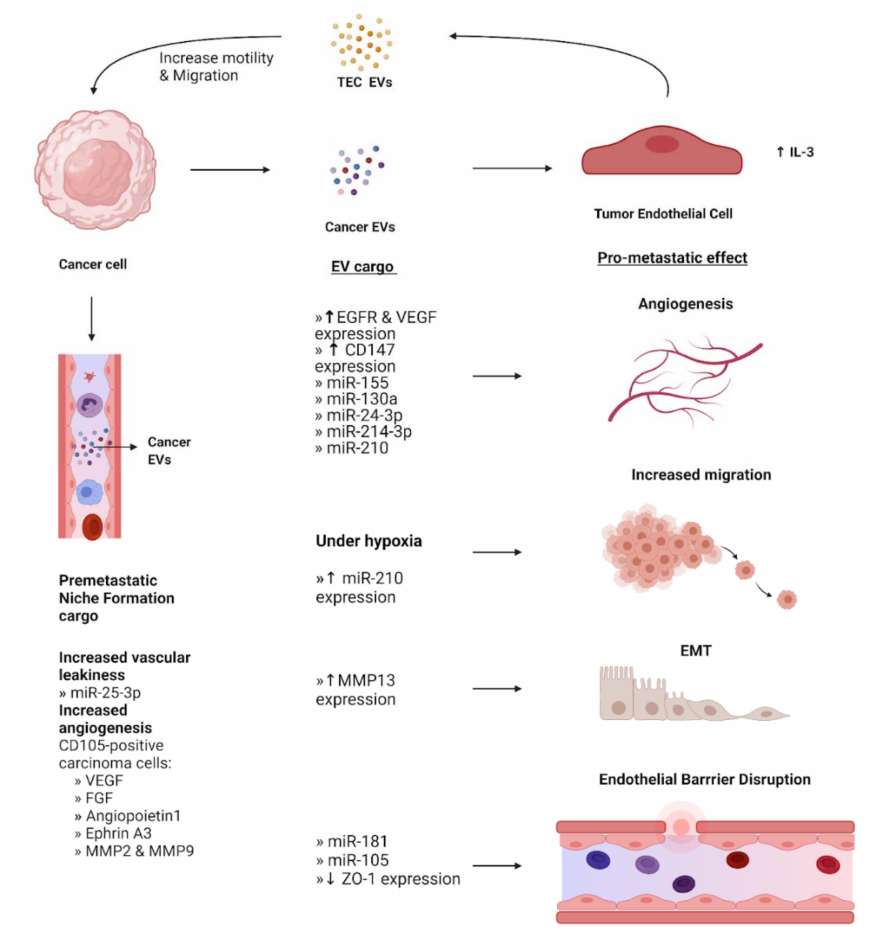
Figure 3. EV-Mediated crosstalk between cancer cells and endothelial cells. EVs containing cargo from cancer cells have various effects in the phenotype of surrounding endothelial cells, converting them into tumor endothelial cells (TECs). These effects include promoting angiogenesis, EMT, and increased migration under hypoxia. Additionally, cancer EVs mediate disruption of the endothelial barrier to aid the intravasation of cancer cells. EVs derived from TECs act on cancer cells to increase their motility and facilitate migration. Concurrently, cancer cells secrete EVs that travel to a secondary site and stimulate local endothelial cells that assist in the formation of the pre-metastatic niche. Expression levels of EV cargo are indicated by upward and downward arrows to represent increase and decrease,